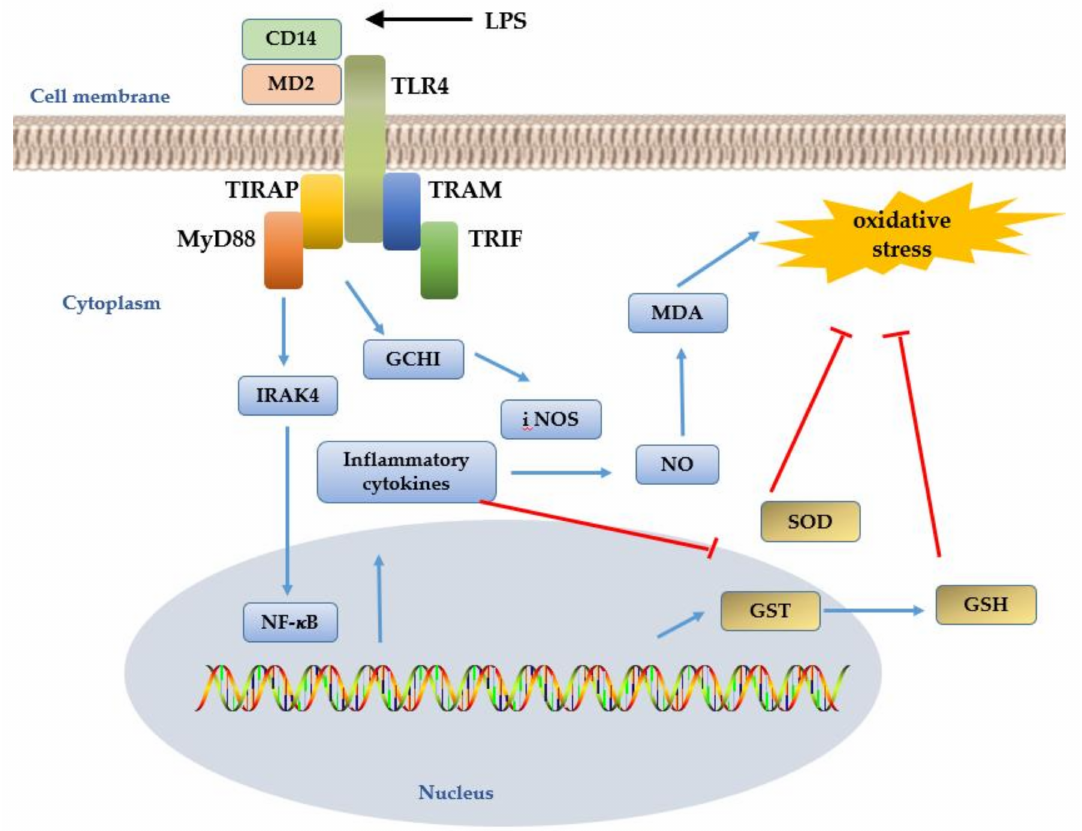
Figure 3. TLR4 signal pathway in oxidative stress [73,75]. TLR4 interacts with myeloid di ff erentiation factor 2 (MD2), CD14, and specific ligand LPS receptors, then recruits downstream adaptors to activate MyD88 − and TRIF-dependent pathway-mediated IRAK4-dependent NF- κ B, which can trigger the transcription-promoting NO (cid:8) . The GCHI-iNOS gene shows a significant increase in the expression of iNOS and NO, which accelerates the inflammatory response by reducing SOD activity and increasing MDA production. GSH eliminates free radicals and prevents oxidative